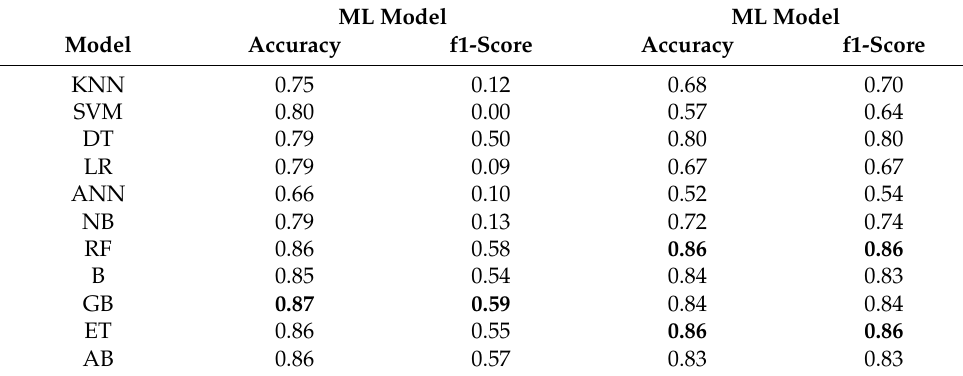
Figure 6. Performance results without balanced data ( a ) accuracy score and ( b ) f1 score. Table 3. Summary of the average cross-validated performance results of the models without and with data balancing. The best scores are highlighted in